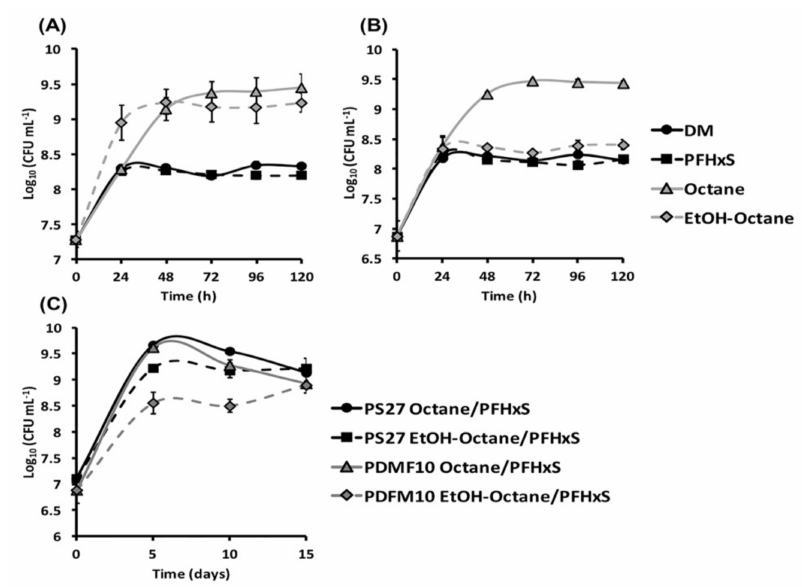
Figure 1. Growth profiles of PS27 ( A ) and PDMF10 ( B ) environmental isolates cultured in DM only or supplied with PFHxS, octane, or the mixture ethanol-octane as the only source of carbon and energy. In ( C ) is shown the trend of bacterial growth while the cells are incubated in DM amended with organic solvents alongside